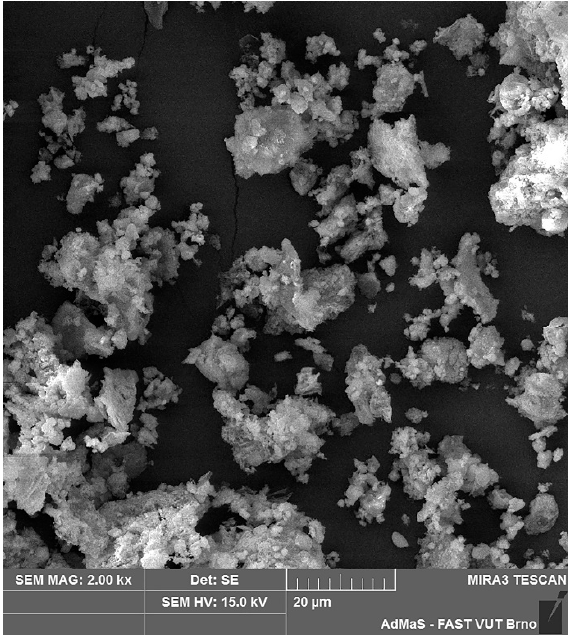
Figure 1. X-ray diffraction pattern of used CCFA.